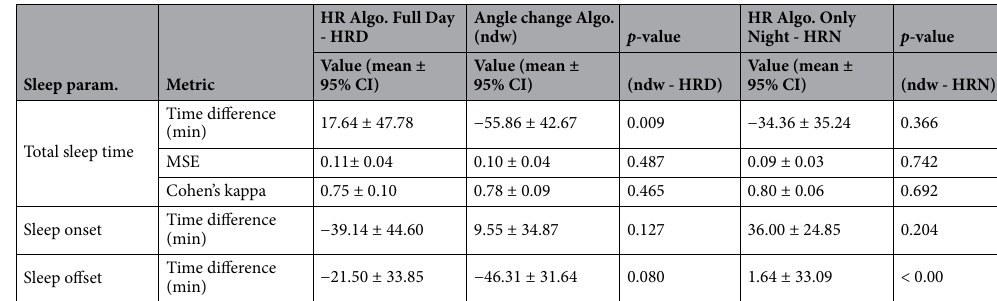
Table 8. Results for the MMASH dataset. The table presents results for both versions of the HR algorithm and compares them to the angle change algorithm for total sleep time, sleep onset and sleep offset in the MMASH